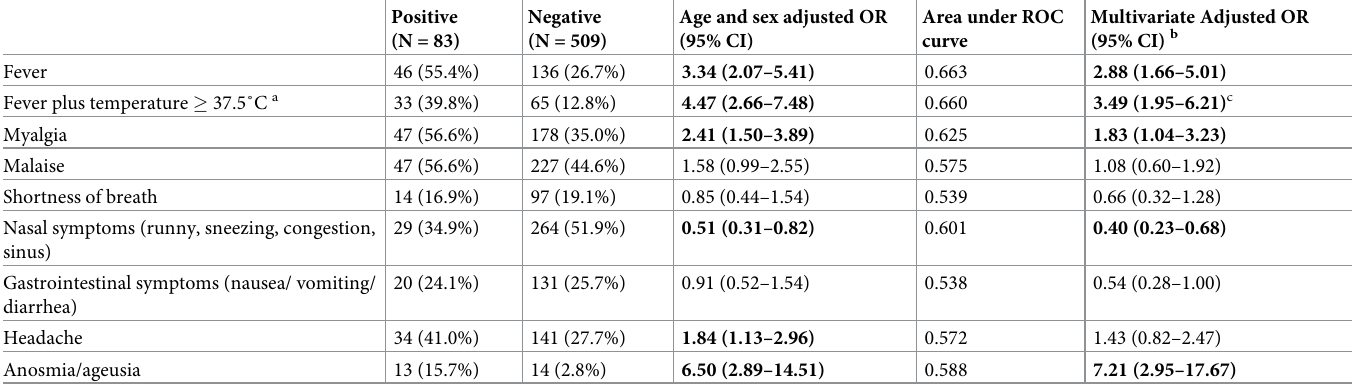
Table 4. Odds ratios of a positive SARS-CoV-2 assay by triage symptom.